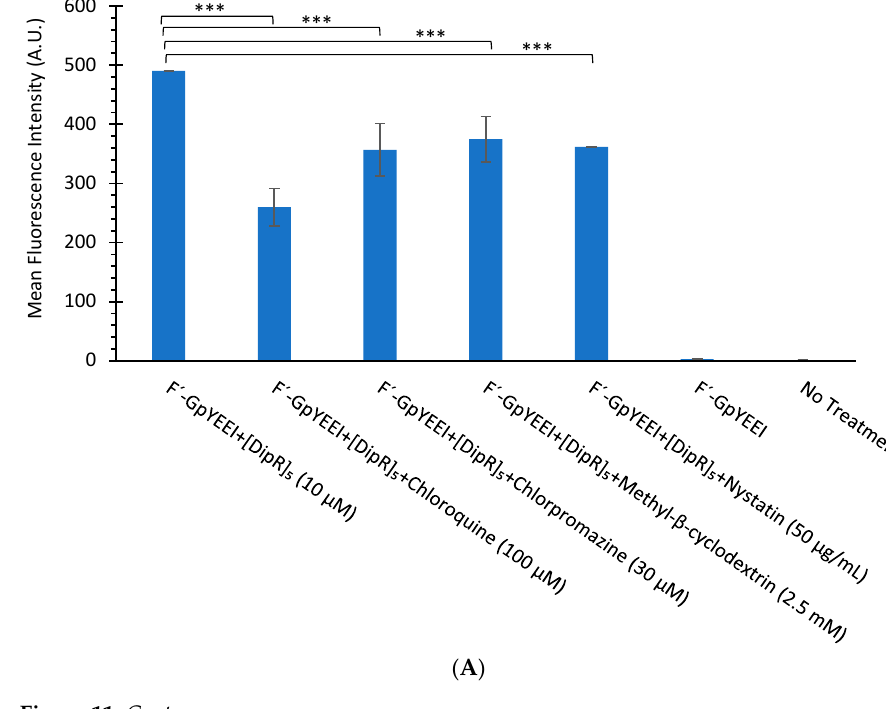
( B ) Figure 11. ( A ) The cellular uptake study of F’-GpYEEI (2 µM) in the presence of [DipR] 5 (10 µM) and endocytosis inhibitors in CCRF-CEM cells after 3 h incubation. ( B ) The cellular uptake study of F’- [K(DipR) 5 ] (10 µM) and endocytosis inhibitors in CCRF-CEM cells after 3 h incubation. Results are mean ± SD (n = 3) (*** p < 0.001). 3.2.4. Circular Dichroism The secondary structures of all peptides were investigated with circular dichroism spectroscopy to determine whether there was any correlation between the